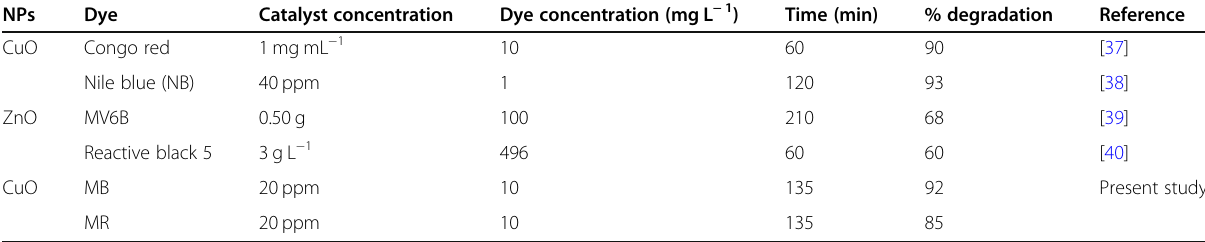
Table 4 Comparative assessment of dyes degradation efficiency using different photocatalysts NPs Dye Catalyst concentration Dye concentration (mg L − 1 ) CuO Nile blue (NB) Reactive black